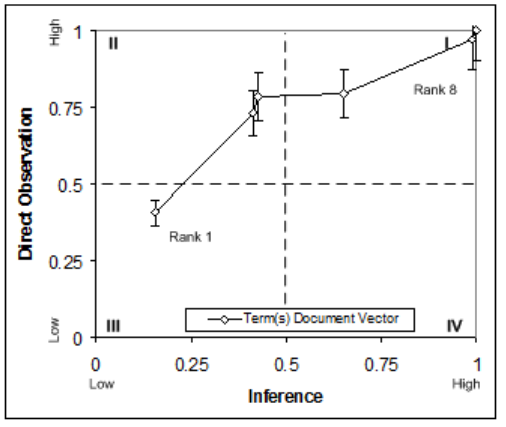
Figure 4. LSA Plot: Toyota’s thinking for accessing information